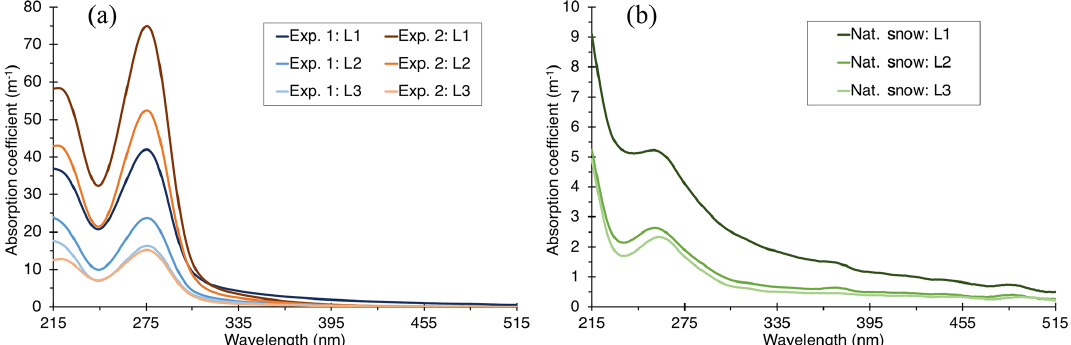
Figure 4. Absorption coefficient of snow meltwater for layers L1, L2, and L3 for deposited BrC (a) and for background impurities occurring in the natural snowpack (b) . “Exp. 1” and “Exp. 2” refer to the first and second BrC deposition experiments, respectively. The spectra of the natural snow (b) have been averaged for two locations at the experiment